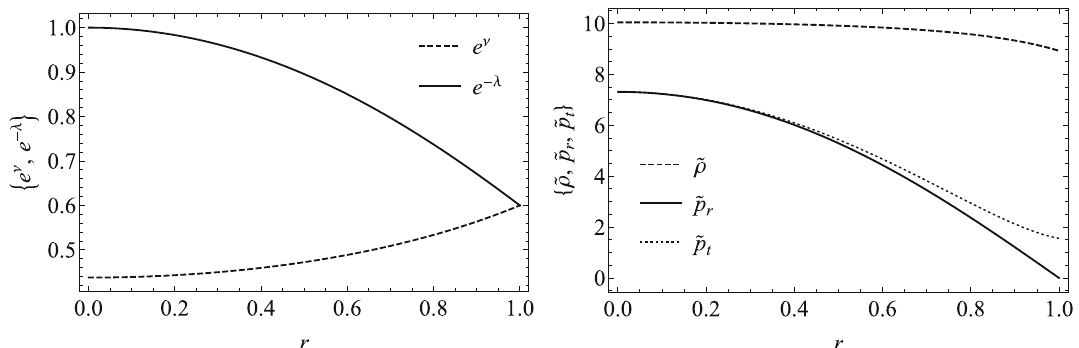
Fig. 3 Metric functions { e ν , e − λ } (left panel) and matter sector { 10 2 × 2 ˜ ρ ,10 3 × ˜ p r , 10 3 × ˜ p t } (right panel) as a function of the radial coordinate r , for M / R = 0 . 2 and C = 1 . 5 for the like-Tolman IV model Fig. 4 Left panel: exchange of energy 10 3 × 2 Δ E for different values of C . Right panel: density plot of the exchange of energy for C = 1 . 5 for the like-Tolman IV model. In both cases M / R = 0 .